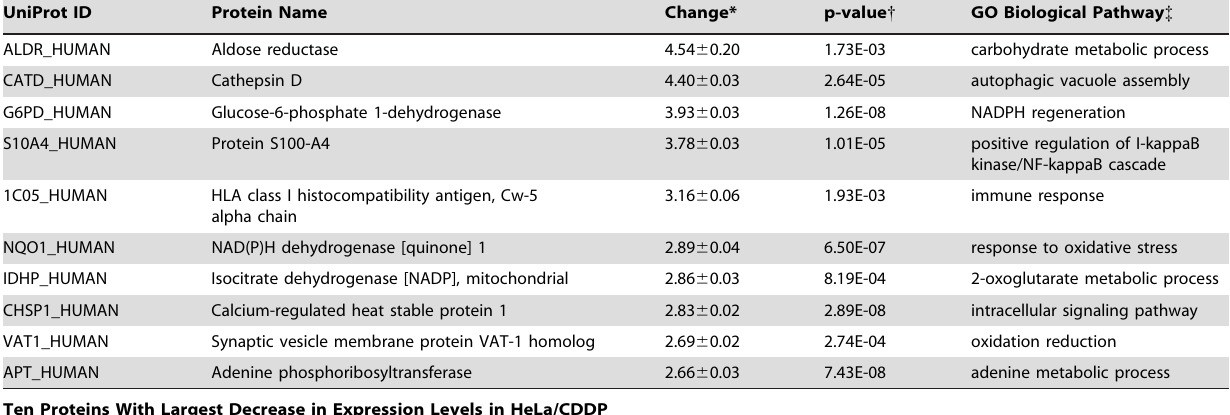
Ten Proteins With Largest Increase in Expression Levels in HeLa/CDDP